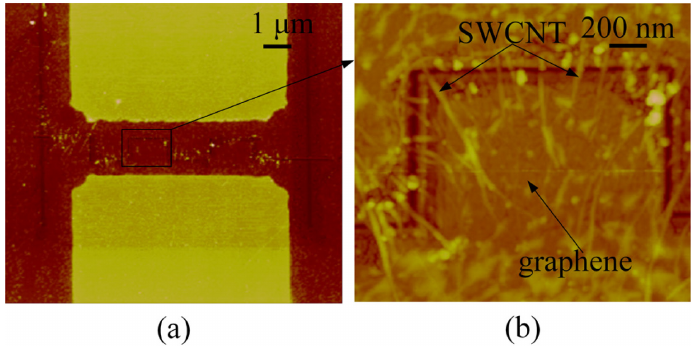
Figure 10. ( a ) AFM image of SWCNT-graphene FET and ( b ) partial enlargement figure of ( a ).